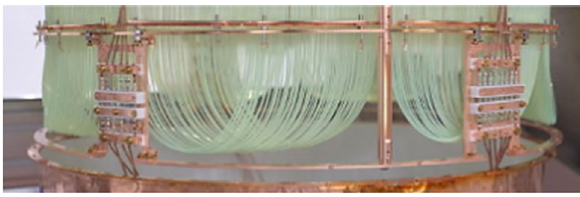
Fig. 12 PMT cable plugs custom made from copper and PTFE allow to separate the bottom LAr veto segment from the central fiber part